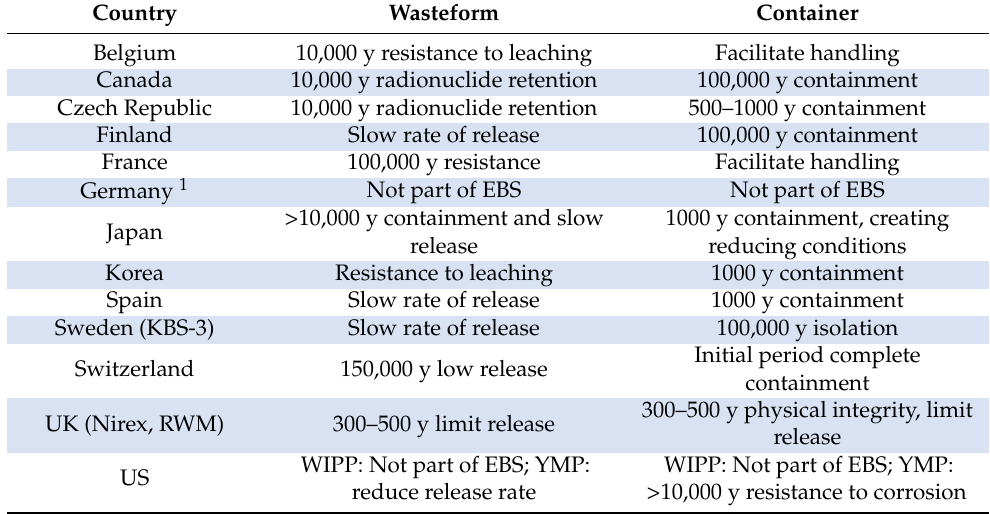
Table 5. Functions of the wasteform (immobilising matrix) and container components of